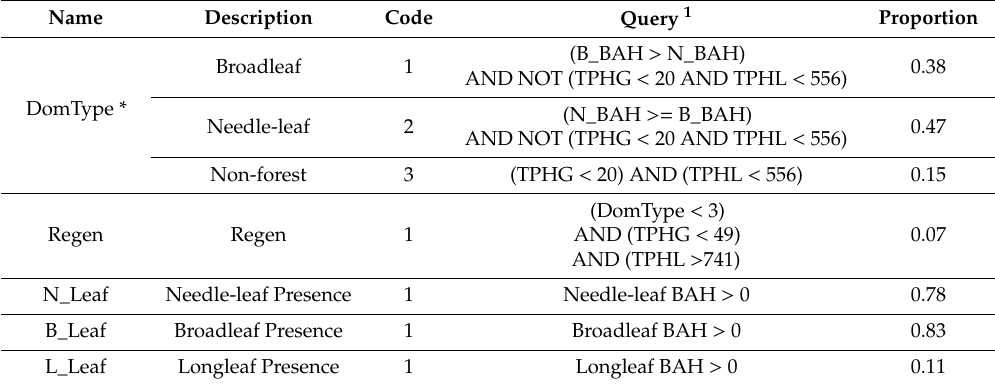
Table 1. The name, description, code, logical rules used to label each class (Query) and proportion of observations that makeup each class within each categorical response